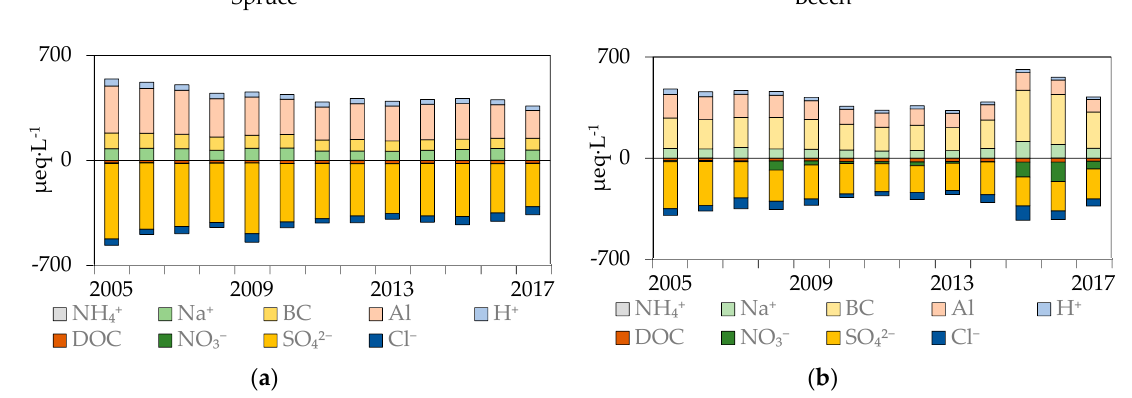
Figure 5. Soil solution concentrations from the depth of 90 cm in the spruce ( a ) and the beech ( b ) stand. DOC, NO 3 − , SO 42 − , and Cl − concentrations were reversed to show how reductions in acid anions were compensated by reductions of base cations, Al and H + .